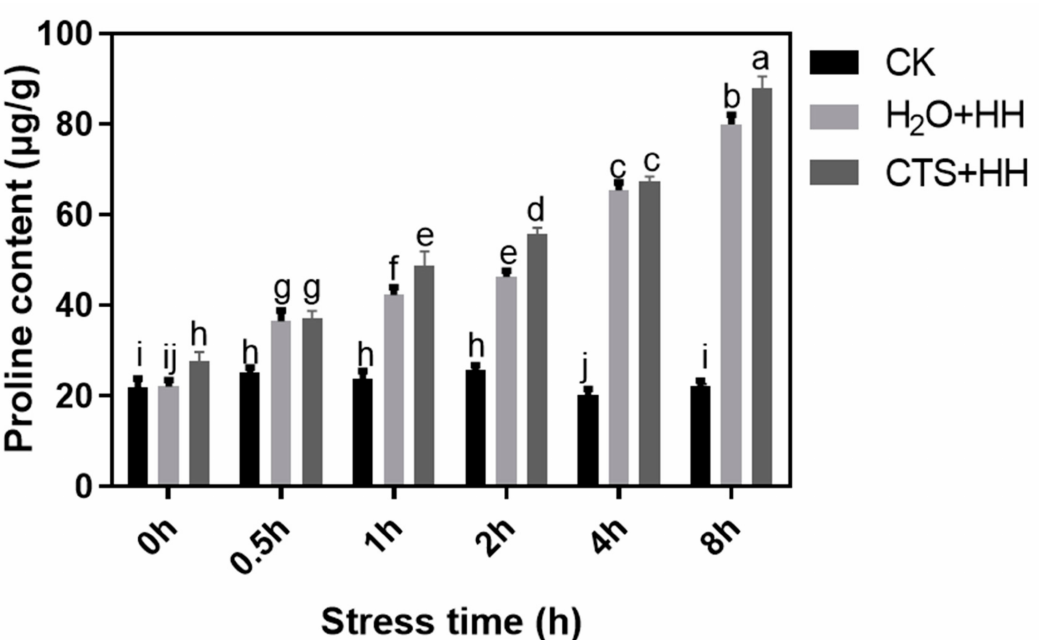
Figure 6. Effects of CTS on the proline content of strawberry seedlings under high-temperature and high-light stress. CK: H 2 O + 23 ◦ C + 400 µ mol · m − 2 · s − 1 ; H 2 O + HH: H 2 O + 38 ◦ C + 1800 µ mol · m − 2 · s − 1 ; CTS + HH: CTS + 38 ◦ C + 1800 µ mol · m − 2 · s − 1 . The different lowercase letters indicate significant differences between the treatments (Duncan’s multiple range test; p < 0.05).